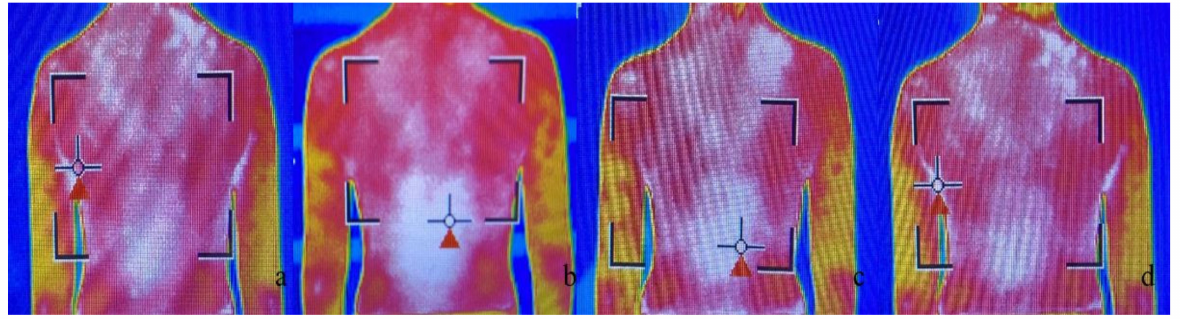
Figure 3. Subject 2 without scoliosis ( a ) image taken at the beginning; ( b ) image taken at the end of exercise 1; ( c ) image taken at the end of exercise 2; ( d ) image taken at the end of exercise 3.